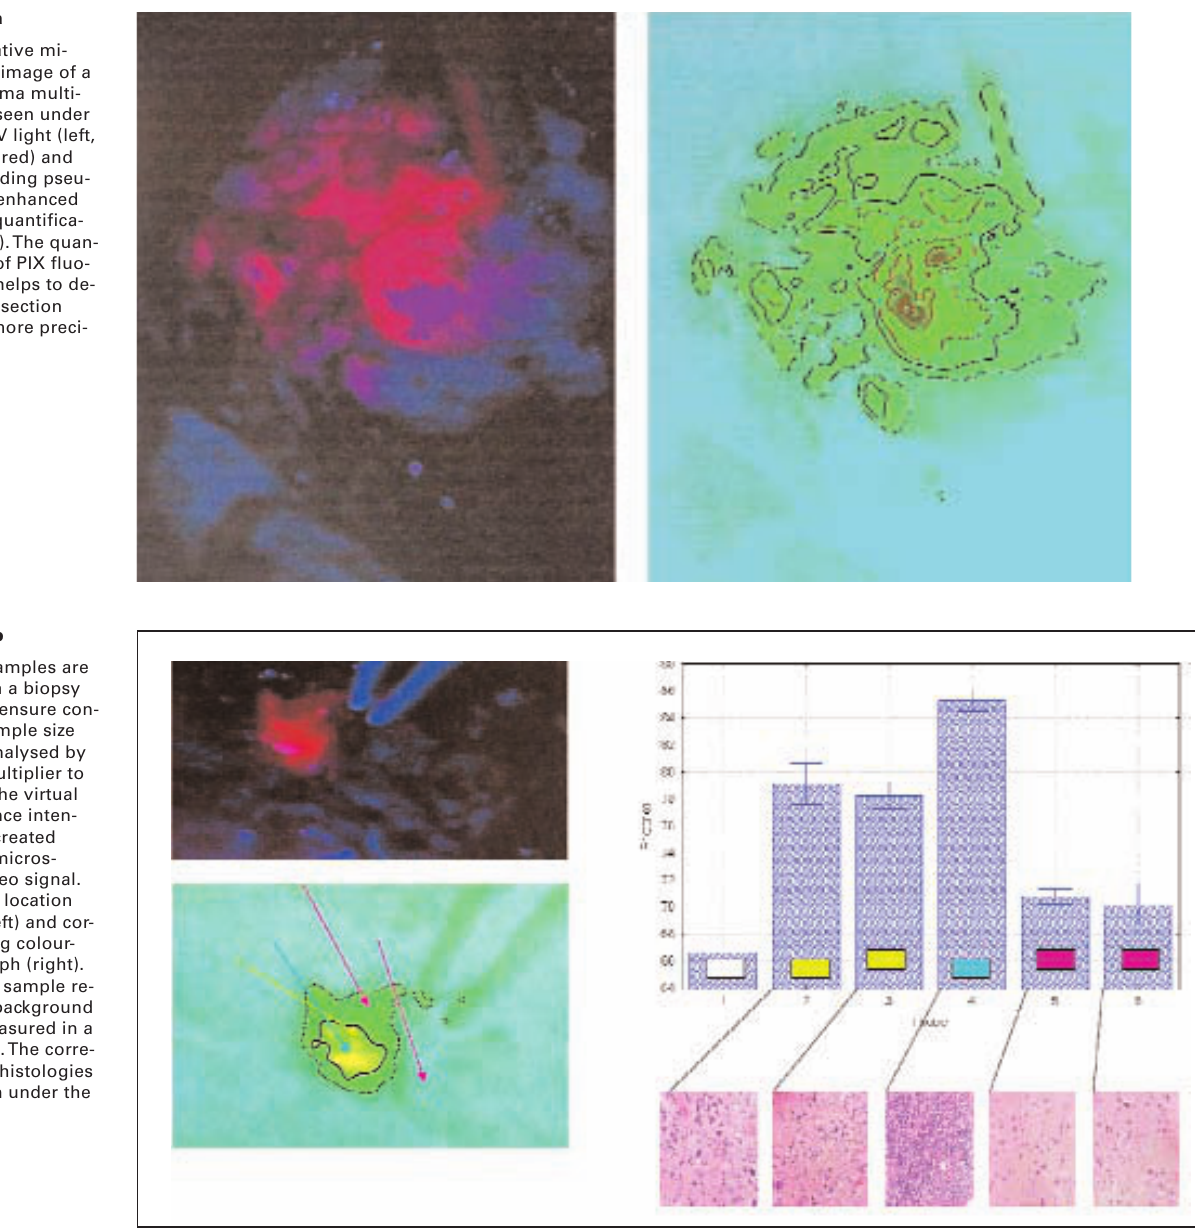
Figure 1a Intraoperative mi- croscopic image of a glioblastoma multi- forme as seen under 440 nm UV light (left, tumour is red) and corresponding pseu- docolour enhanced intensity quantifica- tion (right). The quan- tification of PIX fluo- rescence helps to de- fine the resection margins more preci-